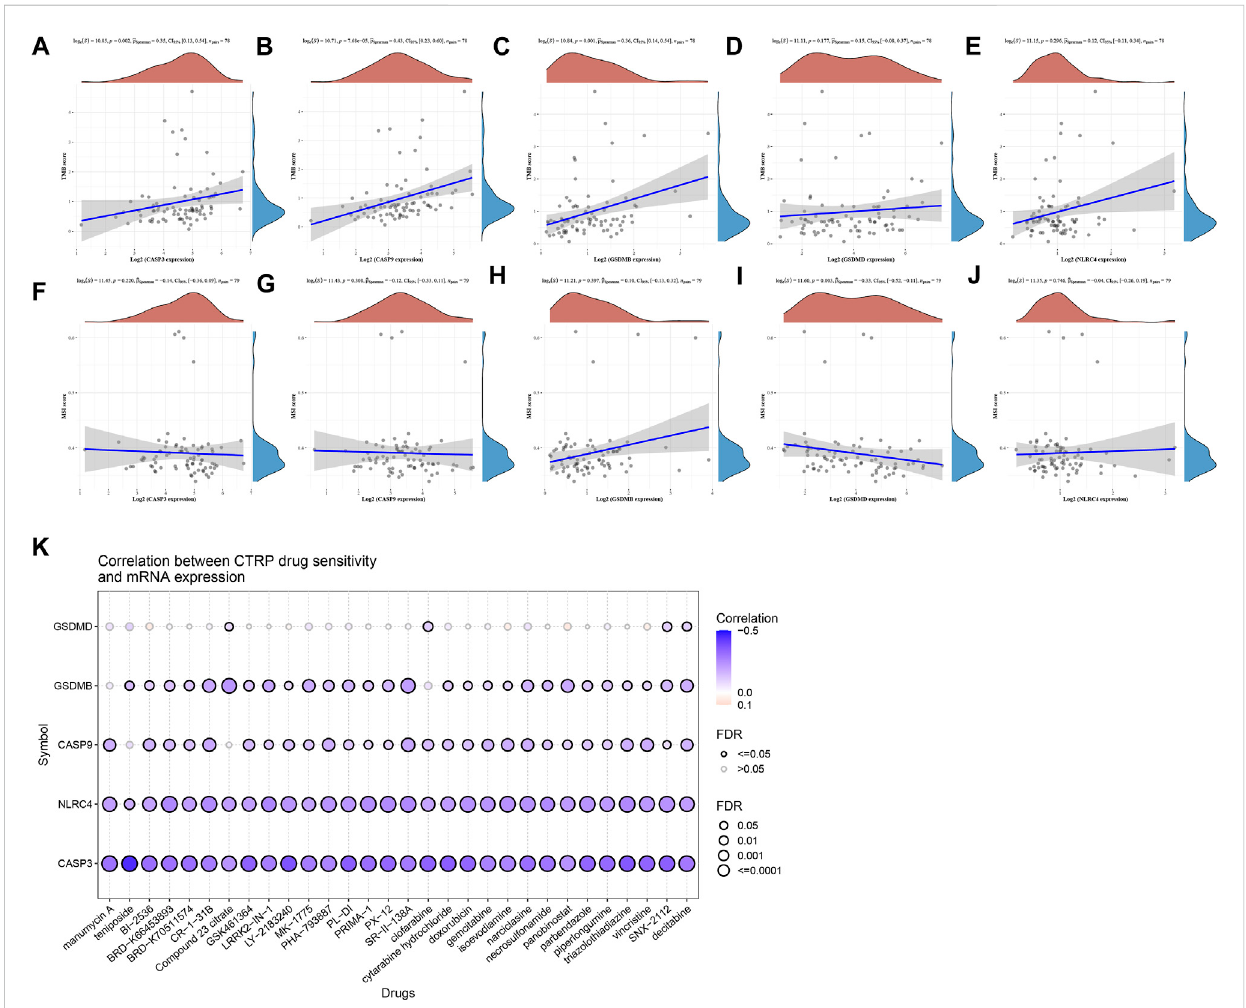
FIGURE 8 TMB, MSI, drug-sensitivity analysis of PRGs in ACC. (A – E) Correlation between fi ve prognostic PRGs and TMB. (F – J) Correlation between fi ve prognostic PRGs and MSI. (K) Drug-sensitivity analysis of fi ve prognostic PRGs in